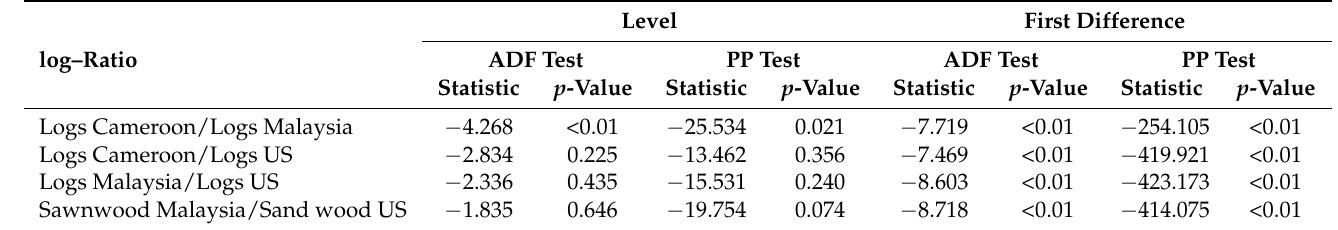
Table 3. Unit root test results for forest products markets pass-through data.